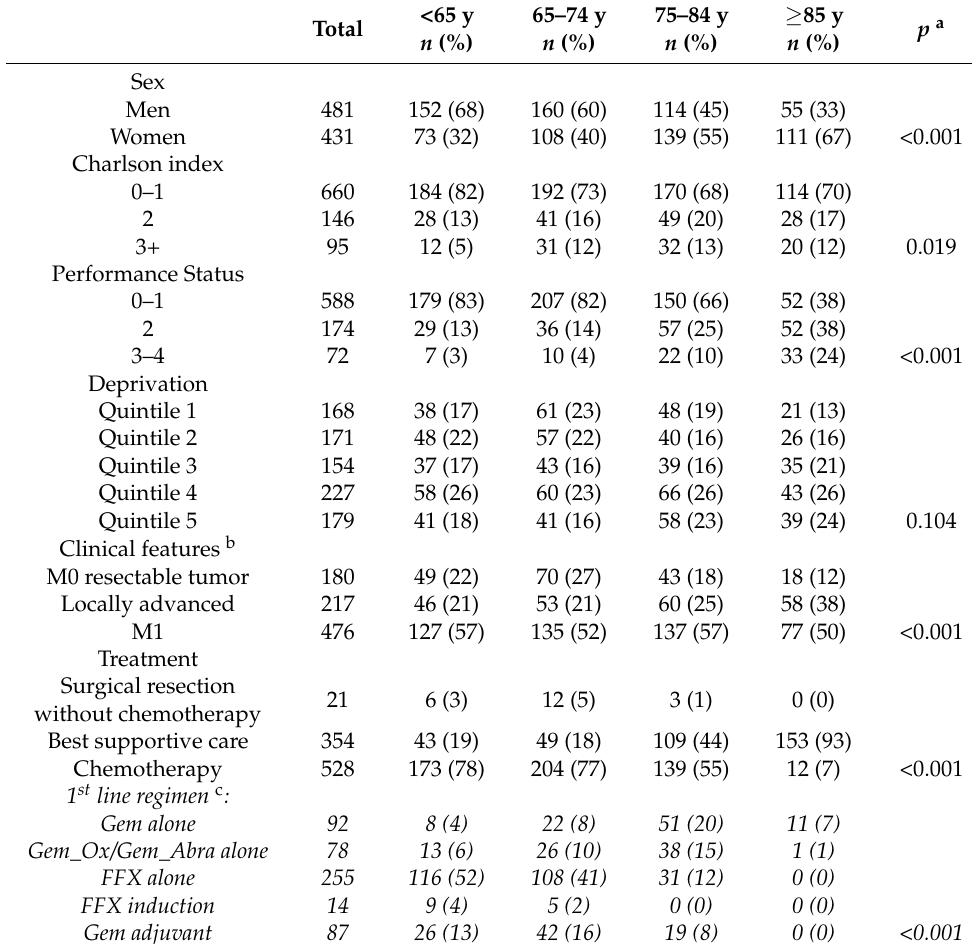
Table 1. Description of the study population according to age at diagnosis of pancreatic cancer ( n =